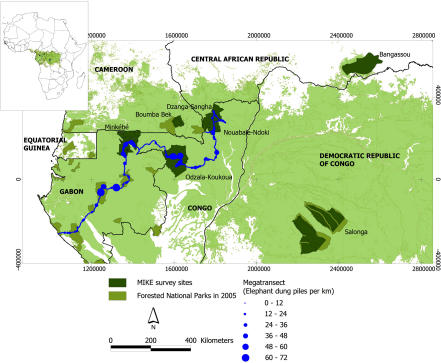
MIKE Survey Sites and the MegatransectNote that the since the Dzanga-Sangha and Nouabalé-Ndoki MIKE sites comprise a contiguous forest block, they were combined into a single unit (Ndoki-Dzanga) for analytical purposes.